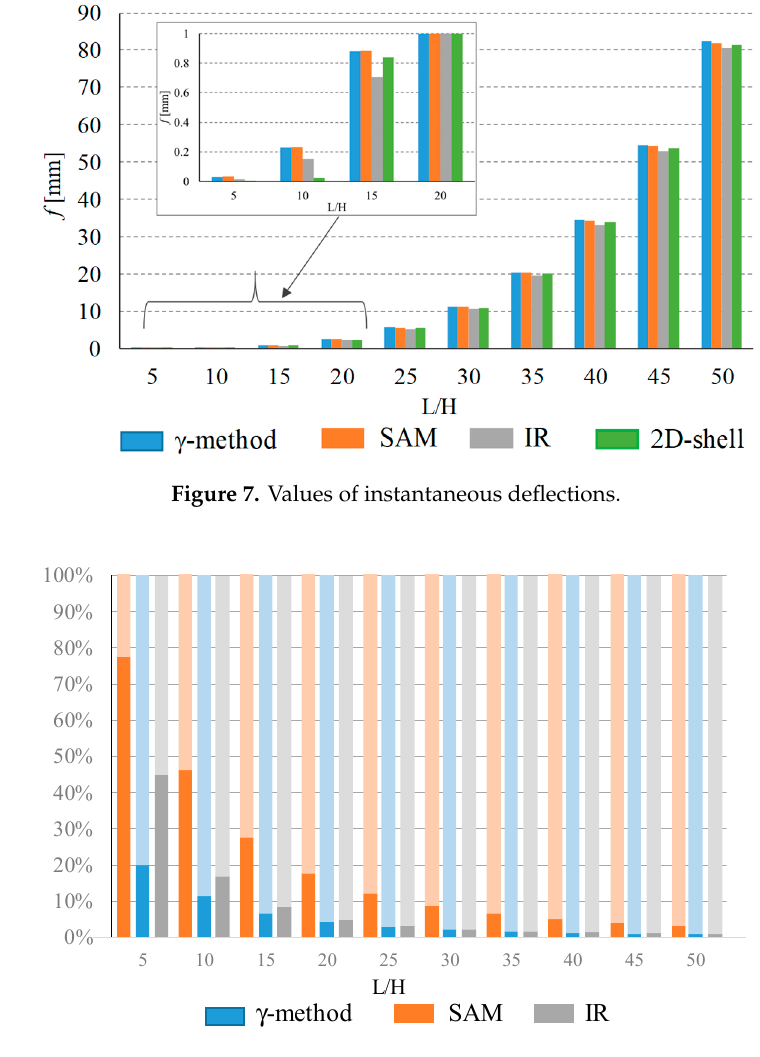
Figure 8. Incidence of rolling shear effect of the total deflection.